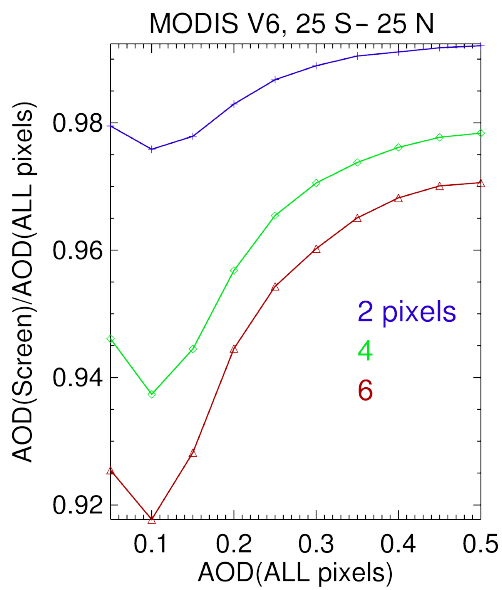
Figure 6. Curves of 1 ◦ × 1 ◦ MODIS V6 AOD averages, calculated with and without cloud pixel-distance screening. x axis AOD values are calculated using all MODIS AOD data, and y axis AODs are calculated by averaging AODs such that the AODs in the 1 ◦ 4 × 1 ◦ geographical area are at 2, 4, and 6 pixel-distances from clouds. Data from 2007–2010, for 25 ◦ S–25 ◦ N, are used.